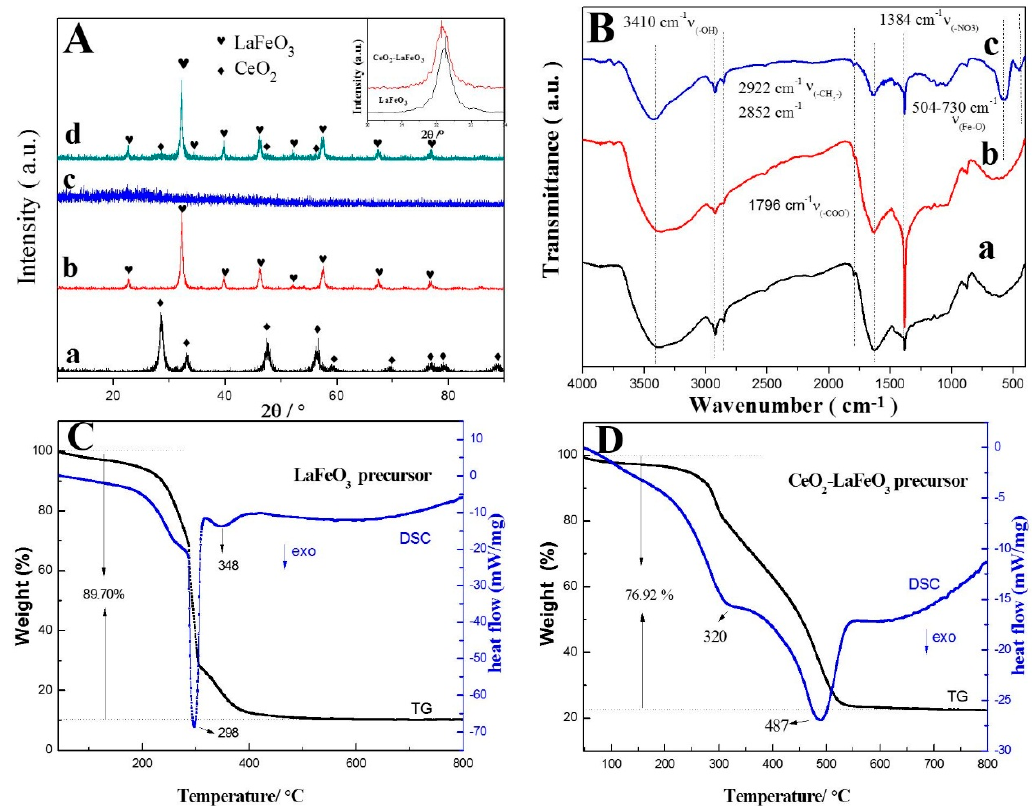
Figure 1. ( A ) XRD spectra of different samples: ( a ) CeO 2 ; ( b ) LaFeO 3 ; ( c ) CeO 2 -LaFeO 3 precursor;